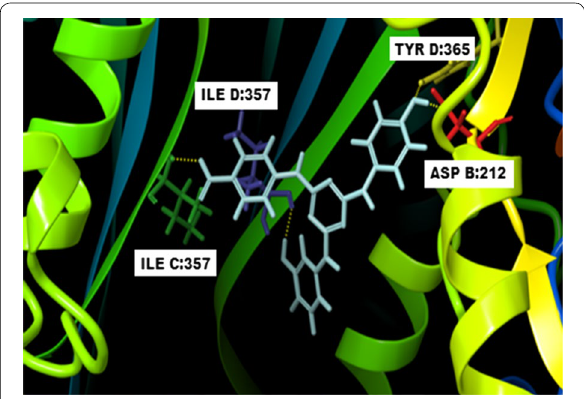
Fig. 2 3-D docked for binding of compound no 7 in the active site of DHFR